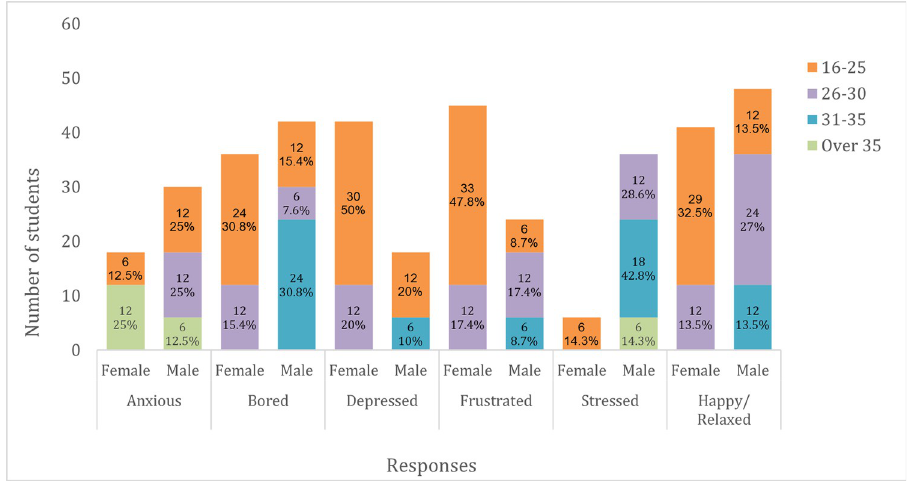
Fig 8. Mental health traits during the